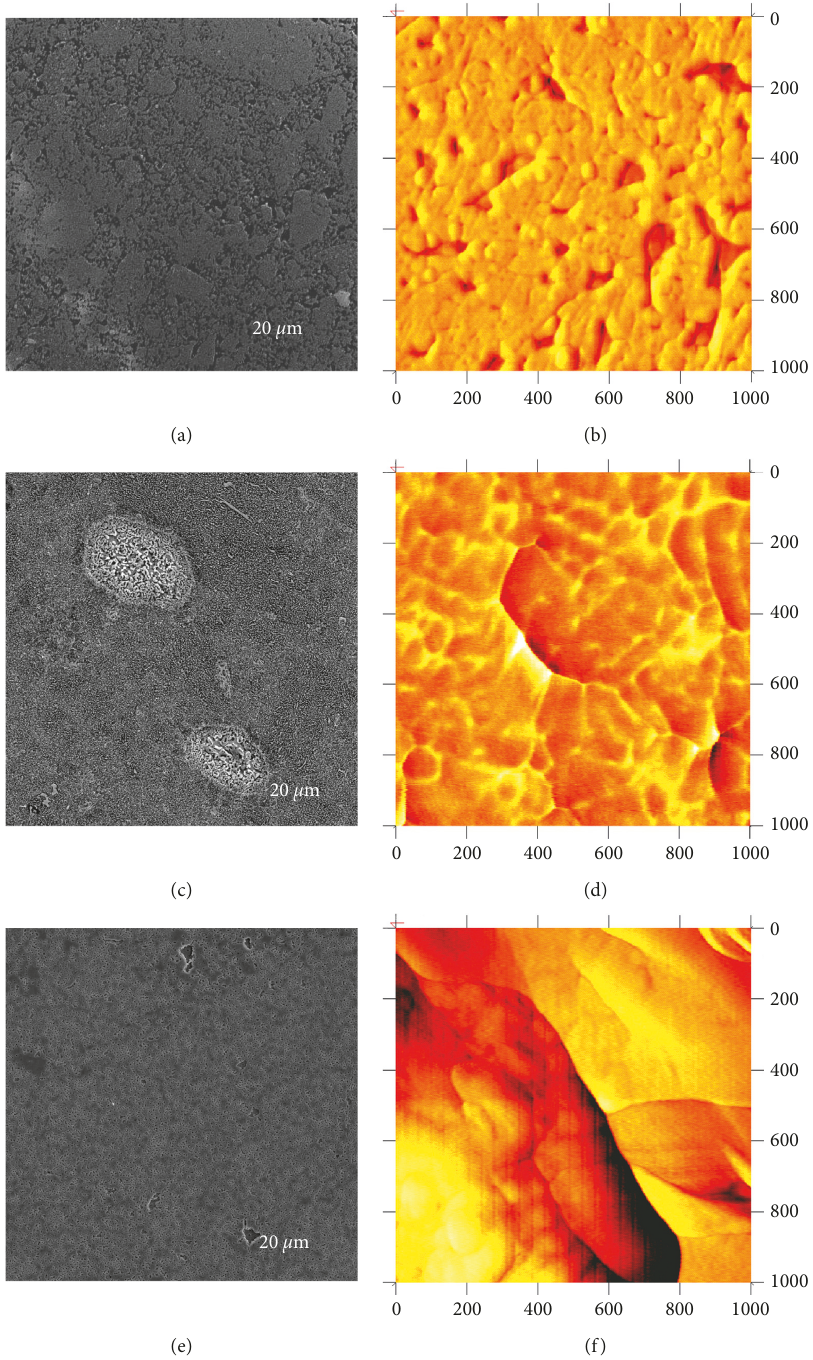
Figure 7: Example of SEM (a, c, e) and AFM (b, d, f) images of the consolidated bulk Ta-40Y